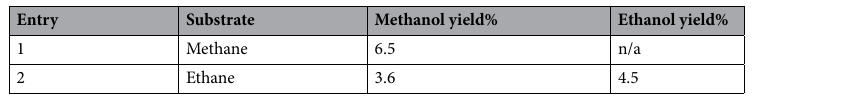
Table 2. The substrate scope of sub-supercritical acetonitrile and boron nitride catalyzed methane activation on C1–C2 hydrocarbon. Yields calculated based on oxygen. Conditions vary. 57 mmol MeCN, 0.60: 1 h